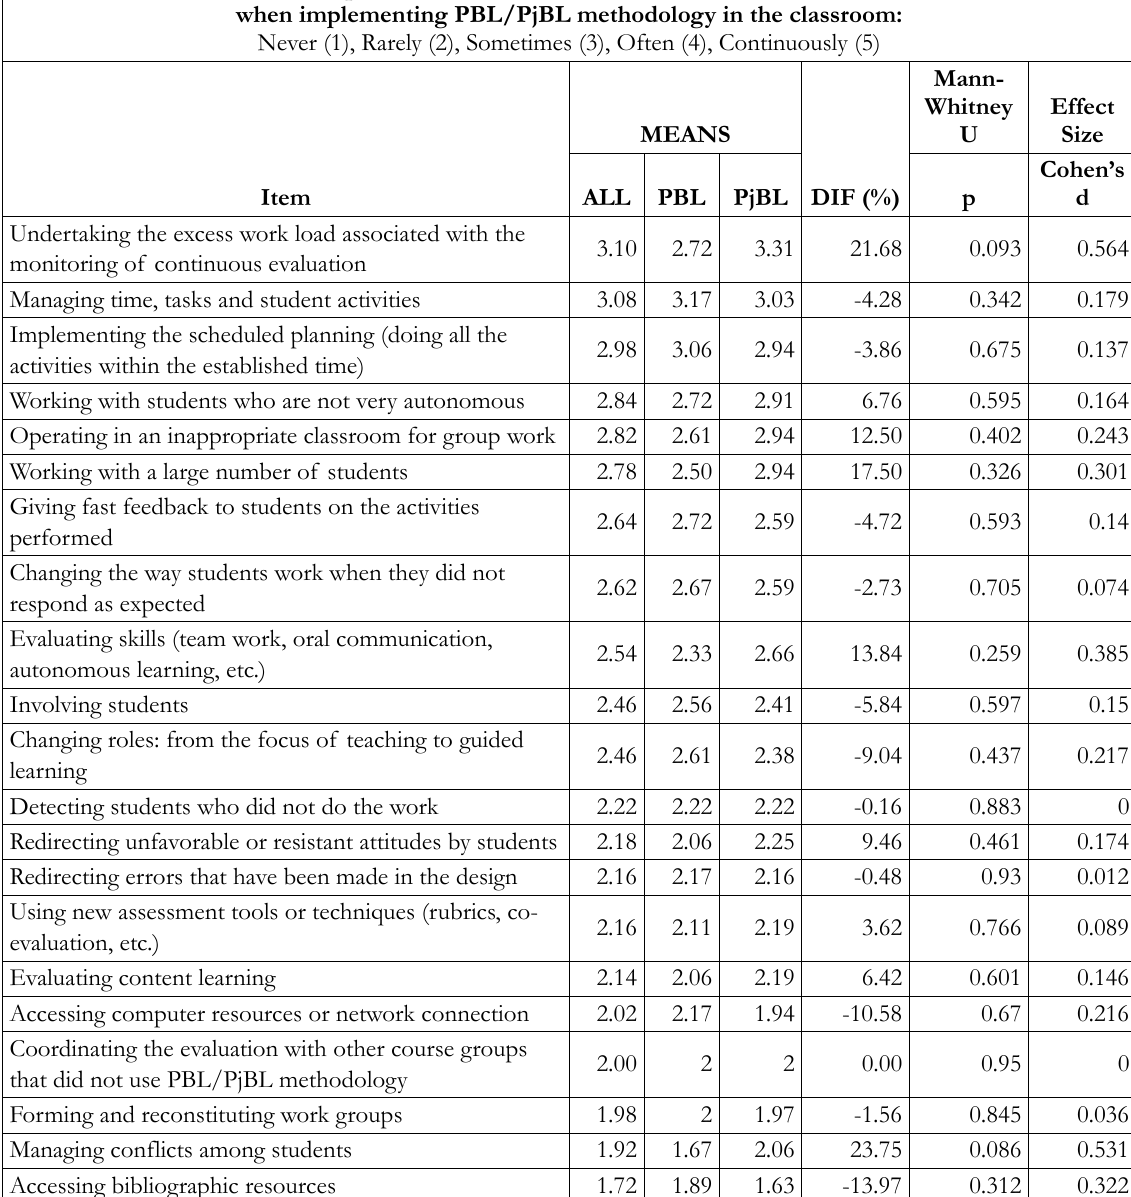
Table 4. Frequency of difficulties encountered when using